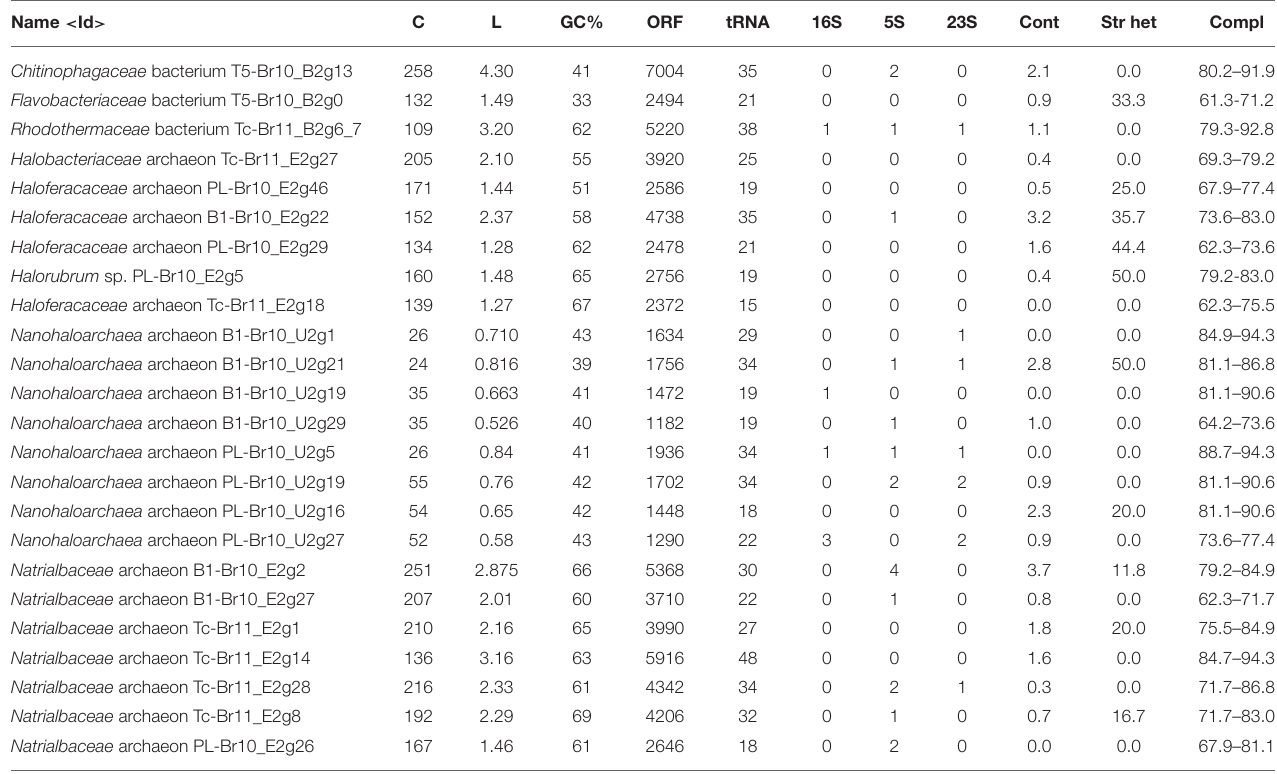
TABLE 3 | Phylogenetic affiliation and general features of selected reconstructed draft